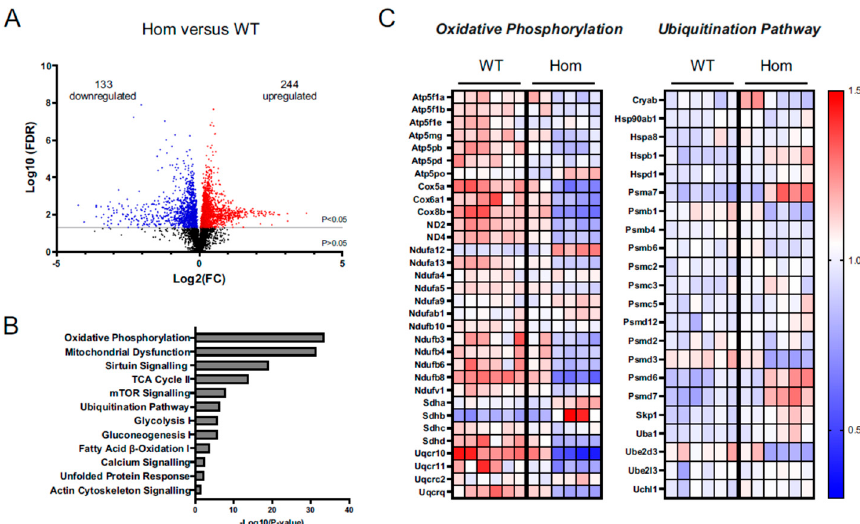
Figure 6. Mass spectroscopy (MS) analysis of WT and Hom hearts at E15.5 ( n = 6 per group). ( A ) Alterations in protein levels between Hom and WT hearts are displayed in a volcano plot that shows 133 downregulated (blue) and 244 upregulated (red) using p < 0.05. Black dots represent protein fold changes at p > 0.05. ( B ) Selected hits of significantly dysregulated canonical pathways identified using IPA. ( C ) Heatmap of protein changes identified using IPA for oxidative phosphorylation and ubiquitination pathway. Colours range from red (increased) to blue (decreased) in WT and Hom hearts based on the relative abundance identified using MS.